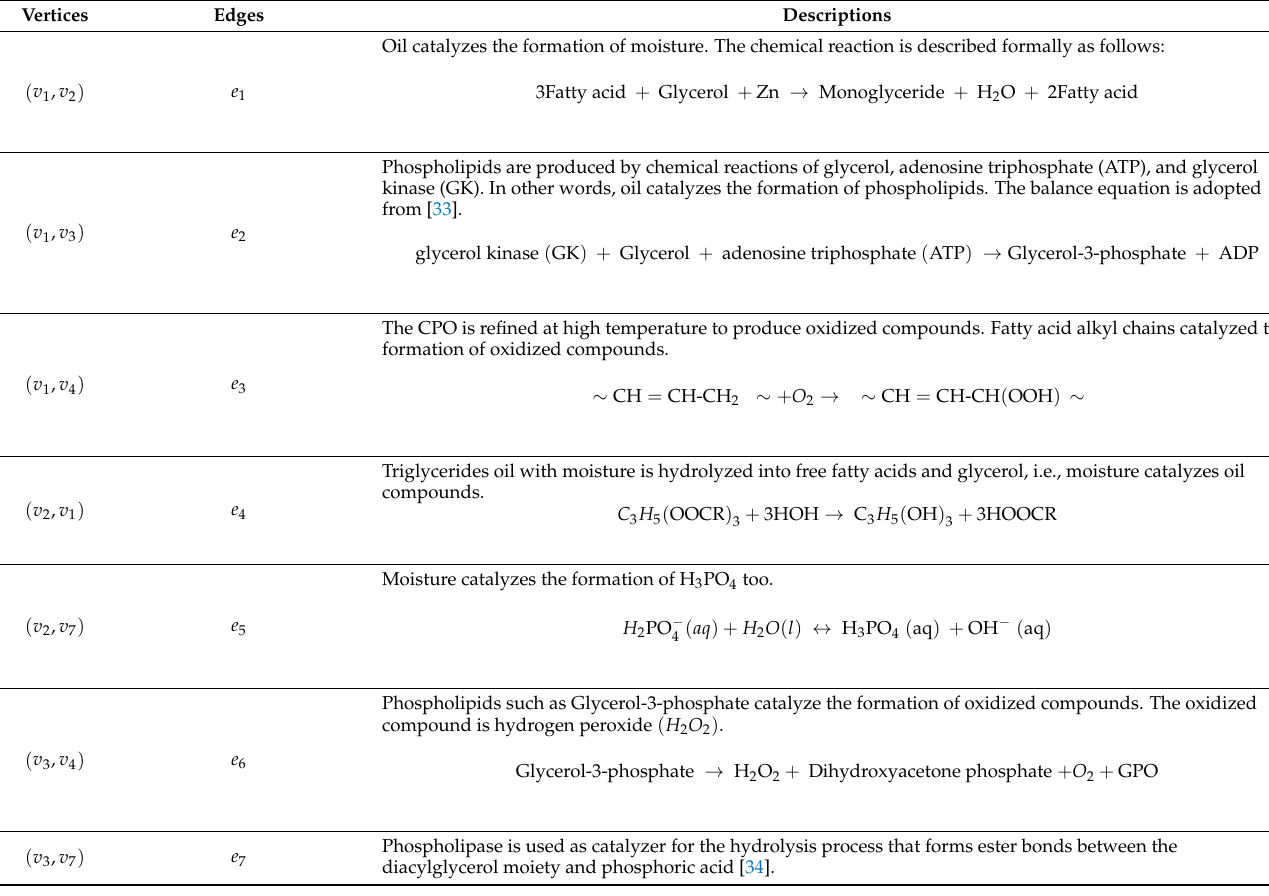
Table 5. The edges for graph 𝐺 (cid:3043) .